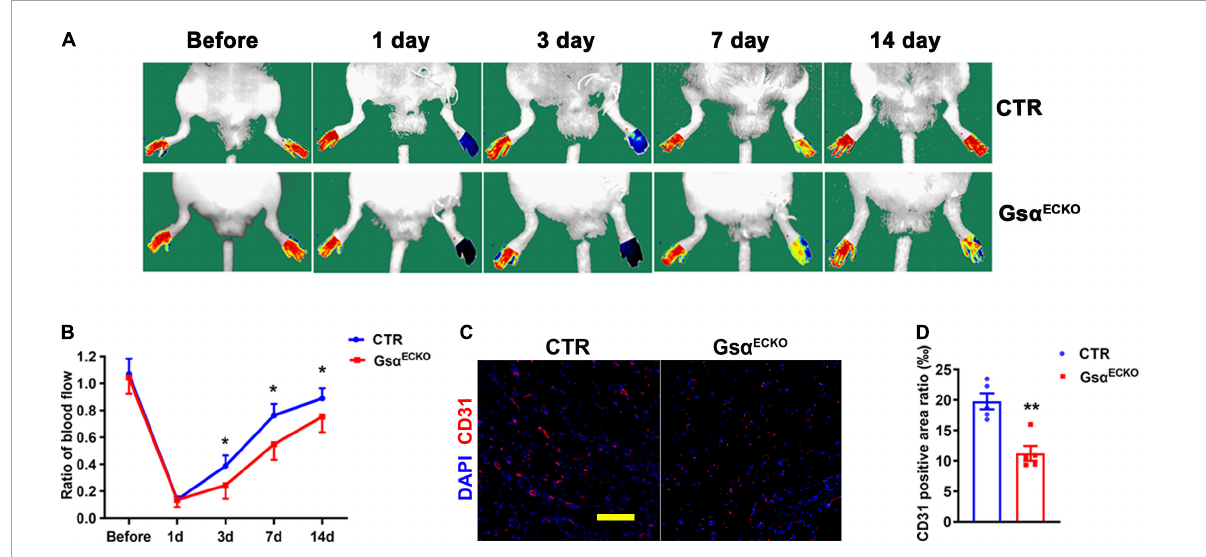
FIGURE2 Endothelial Gs α deficiency impairs blood flow recovery after ischemic injury. (A) Representative images of laser doppler blood flow before or on days 1, 3, 7, and 14 after femoral artery resection. (B) Blood flow in ischemic hind limbs. Data are expressed as a ratio of ischemic to non-ischemic limb perfusion. n = 6/group. (C) Representative immunofluorescence staining at day 14 of CD31 for endothelial cells and DAPI for nuclei in gastrocnemius muscle from ischemic hind limbs of CTR and Gs α ECKO mice. Scale bar, 100 µ m. (D) Quantification of CD31-positive area in (C) , n = 5/group, * P < 0.05, ** P < 0.01 vs. CTR (unpaired Student’s t -test). Data are mean ±